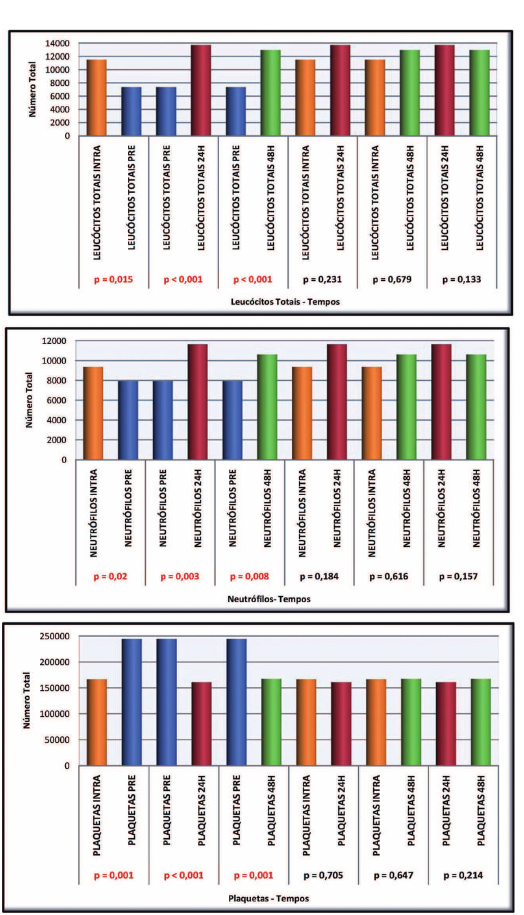
Fig. 1 – Comparação concomitante entre os momentos de observação para leucócitos totais, neutrófilos e plaquetas